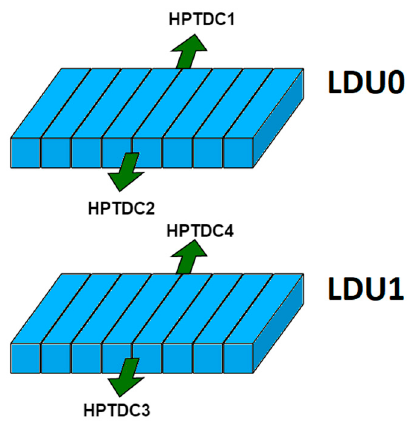
Figure A1. Numbering of the HPTDCs that read out signals from the scintillator bars of the LIDAL detector. Each HPTDC processes signals coming from the same ends of the scintillators of an LDU.